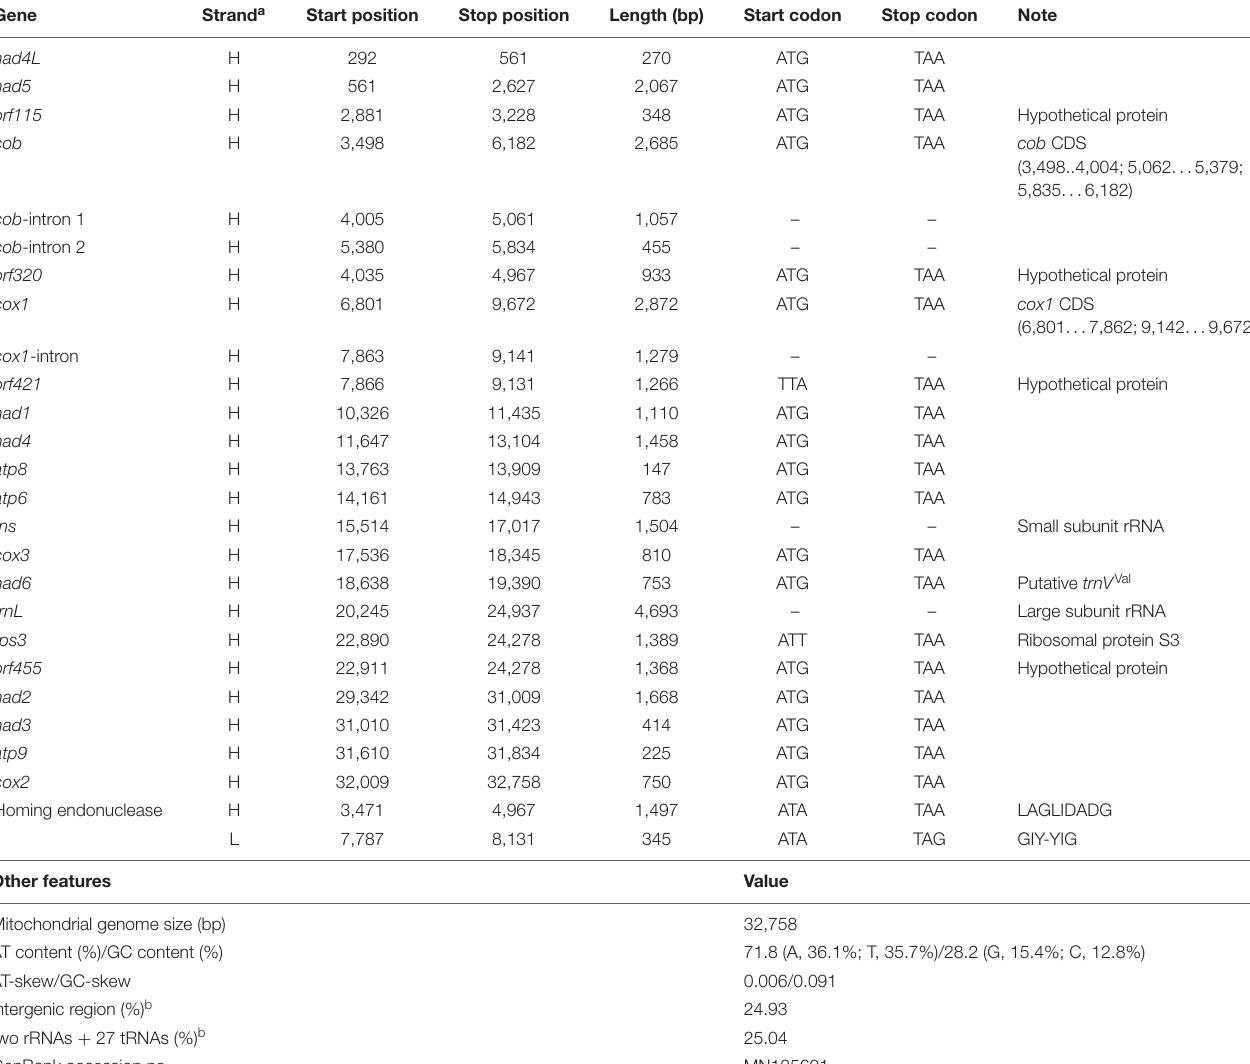
TABLE 1 | Genomic organization of the T. atroviride ATCC 26799 mitochondrial genome. Gene Strand a Start position Stop position Length